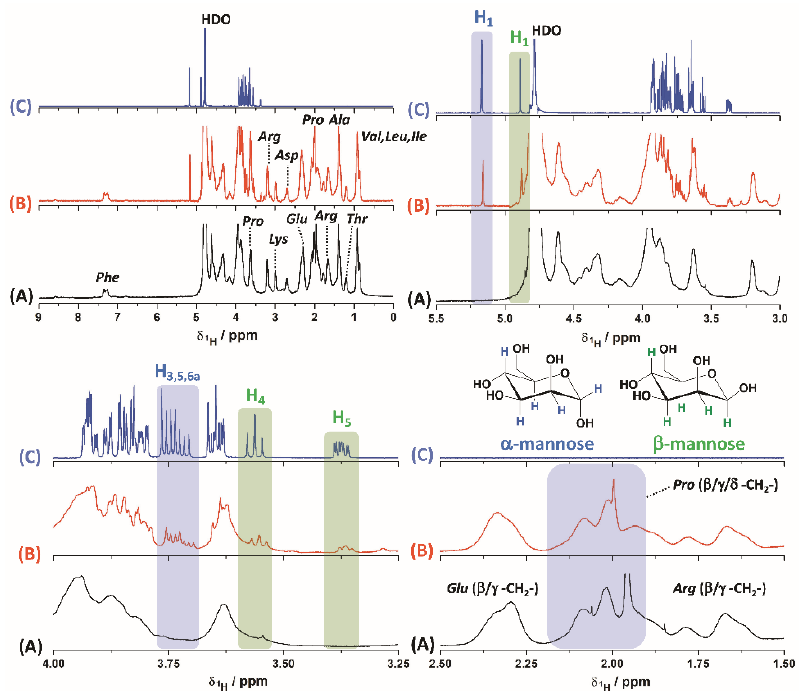
Figure 2. 1 H-NMR spectra for gelatin (A), mannose-modified gelatin (B) and mannose (C) dissolved in D 2 O. Different regions are shown for each of the samples for better understanding. The hydrogens of the α - and β -anomers for D-mannose are drawn with different colors for the assignments of the NMR signals.